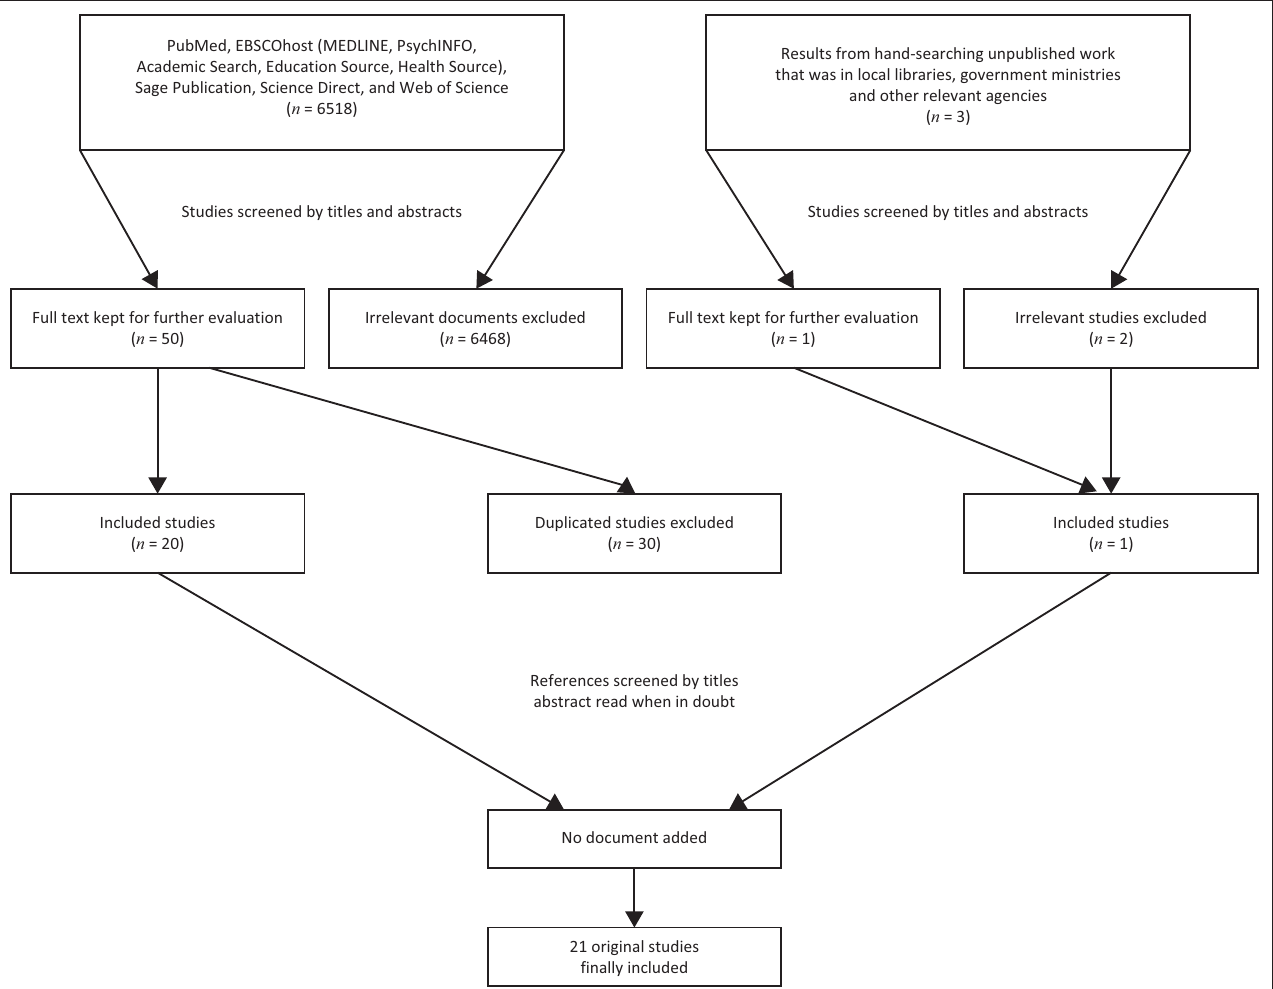
FIGURE 1: Flow chart for the selection of